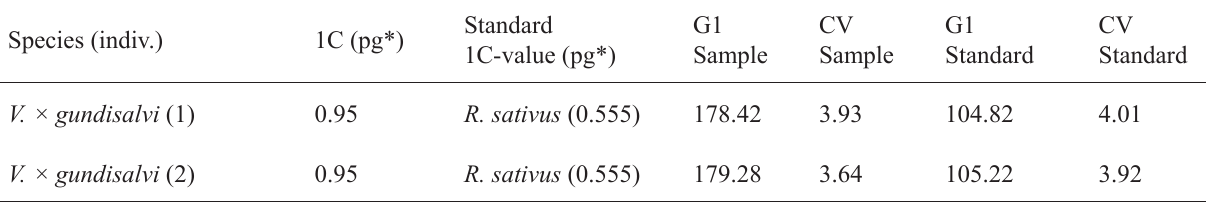
Table 1. Information on ploidy level estimations. The asterics indicate pictograms. Species